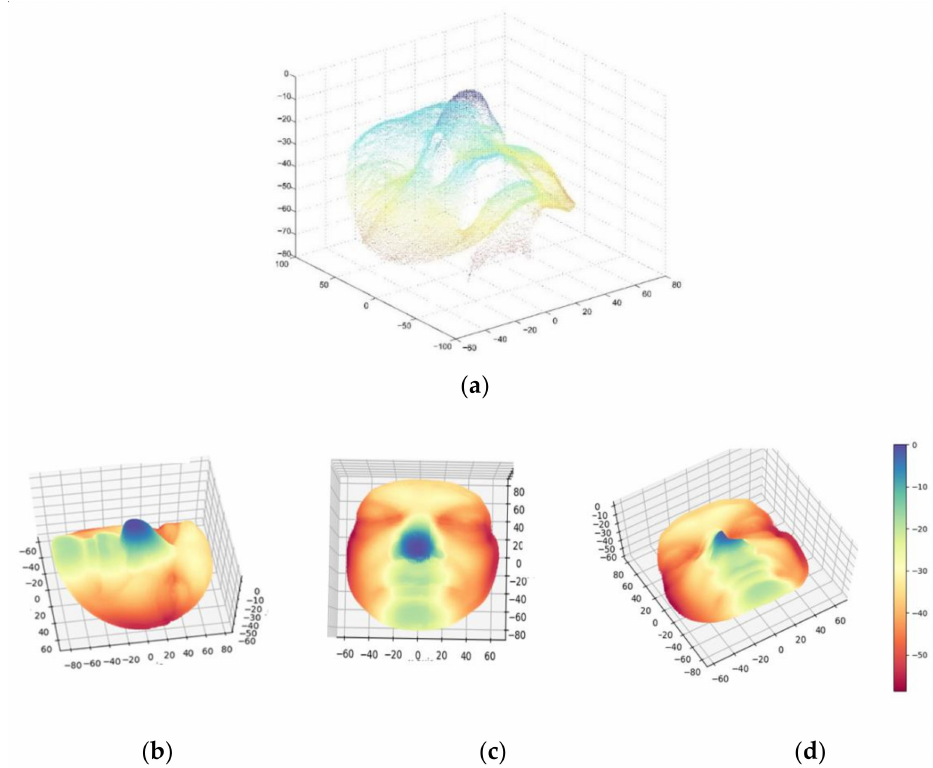
Figure 1. The pre-processed results of a 3D point cloud image, where ( a ) is the face scanned from the devices, and ( b – d ) are the 3D face after removing outliers, interpolation operation, and smoothing from three angles. The values of the Z -axis in an image represent the distance between each point of the face and the tip of the nose, where red-colored dots are farther from the tip of the nose, and dots become more blue as the distance to the tip of the nose decreases.